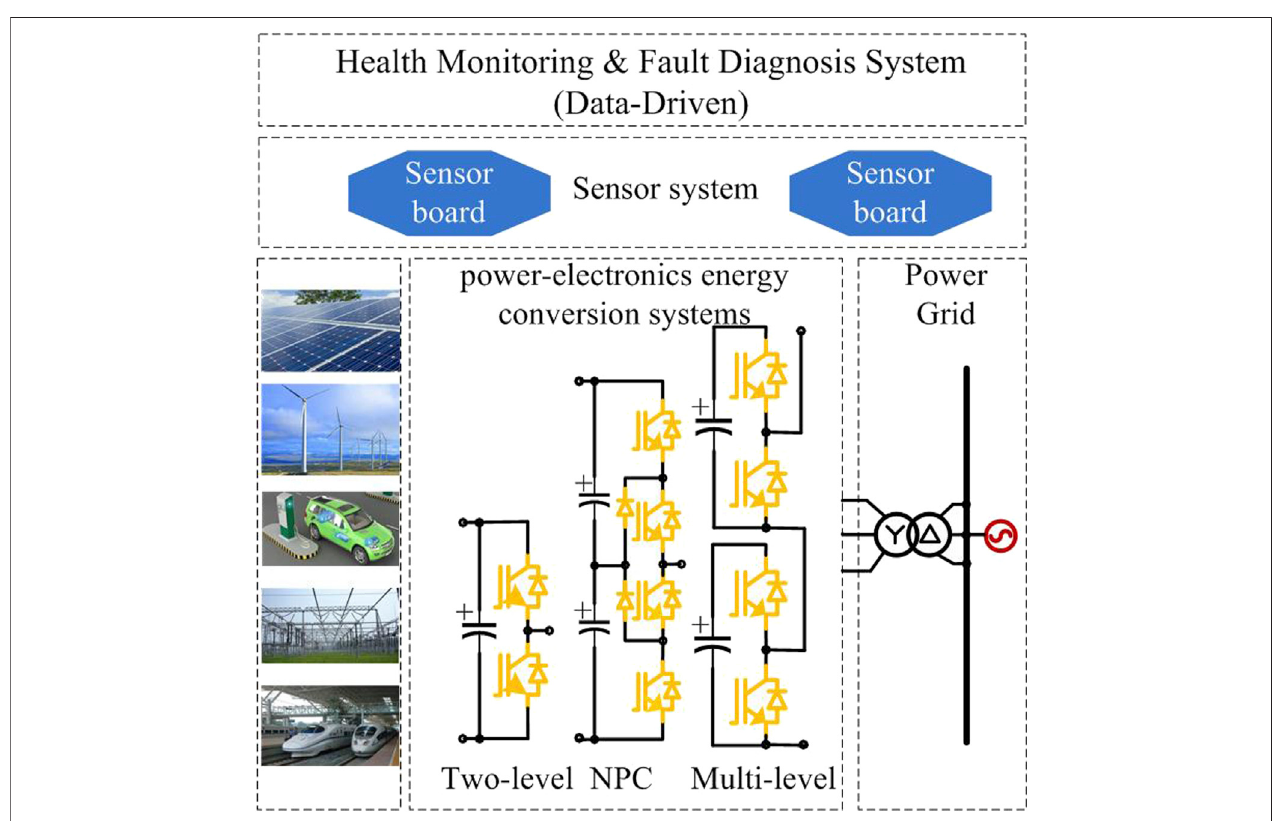
FIGURE 1 | Sensor fault diagnosis and health monitoring system.